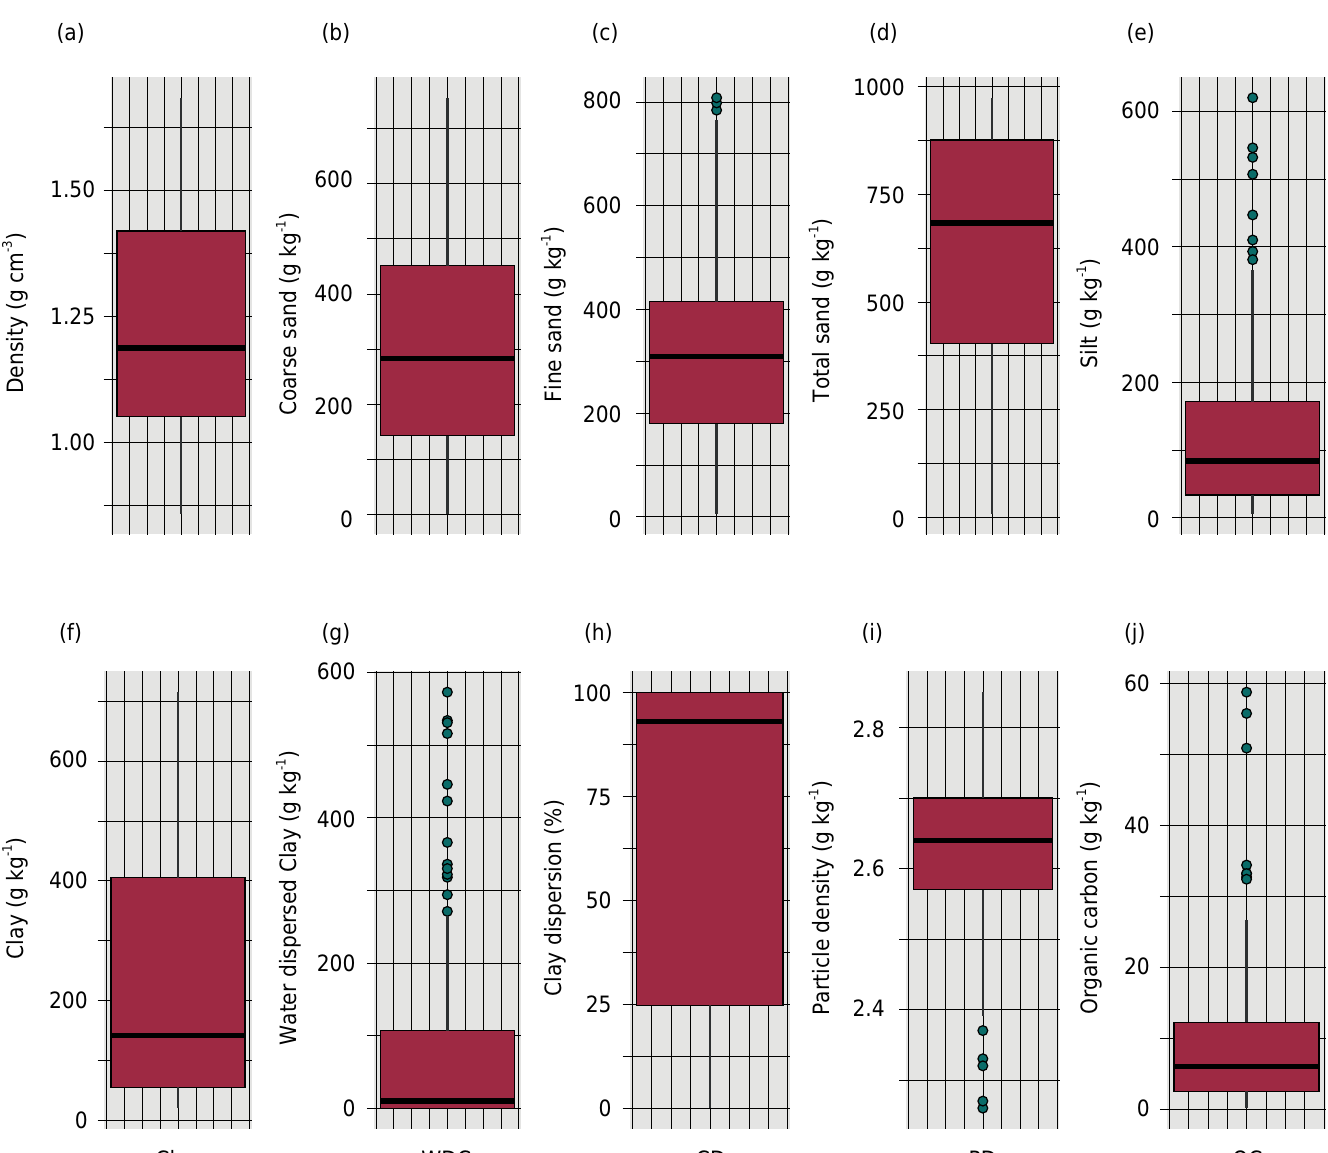
Figure 2. Soil properties boxplots ( n = 132) of different soil classes of Brazil. PD: particle density; OC: organic